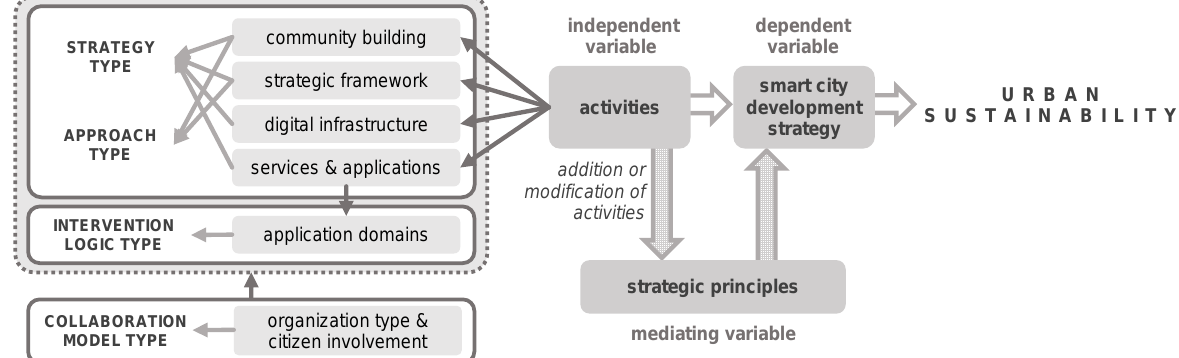
Figure 1. Conceptual model of smart city development for urban sustainability (created from Mora and Deakin,